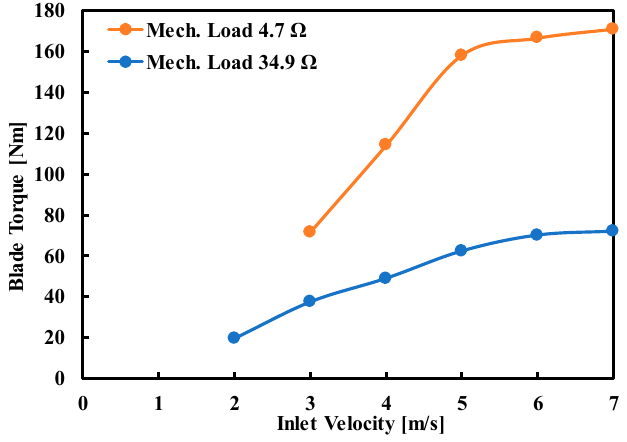
Figure 23. Blade torque vs. Inlet velocity.